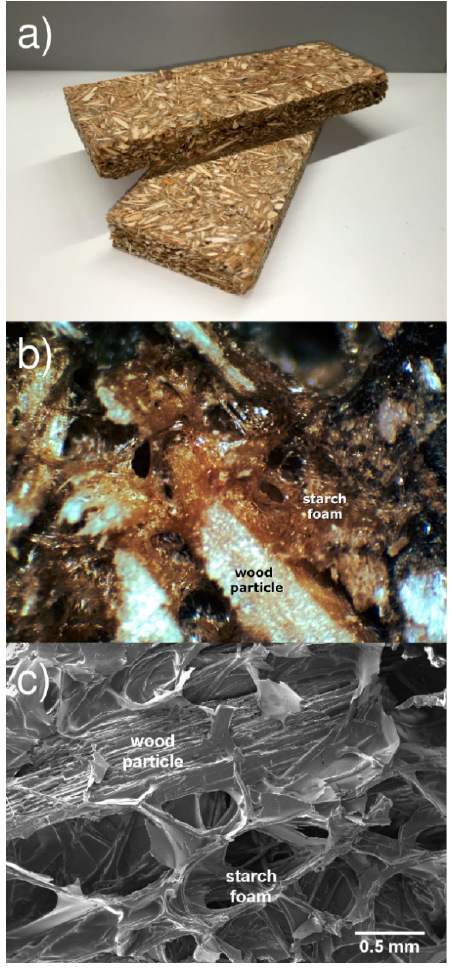
Figure 4. Particleboards produced with sour cassava starch–based binder. ( a ) Outside appearance; ( b ) close-up detail; ( c ) SEM image showing wood particles and surrounding foam, 100× magnification.